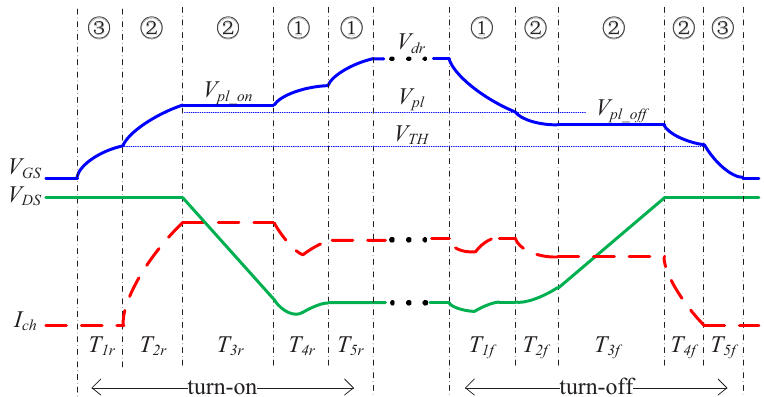
Figure 2. The turn-on sequence and turn-off sequence of a power MOSFET with a clamped cur- rent